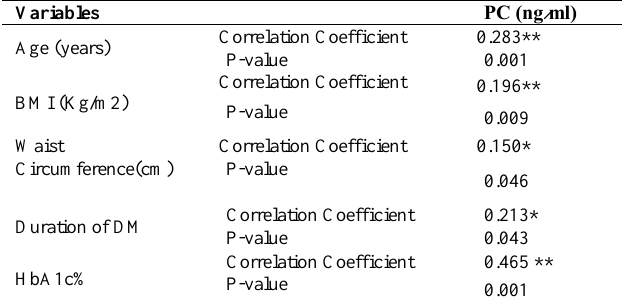
Table 5: Correlation of the study variables with PC levels in the study